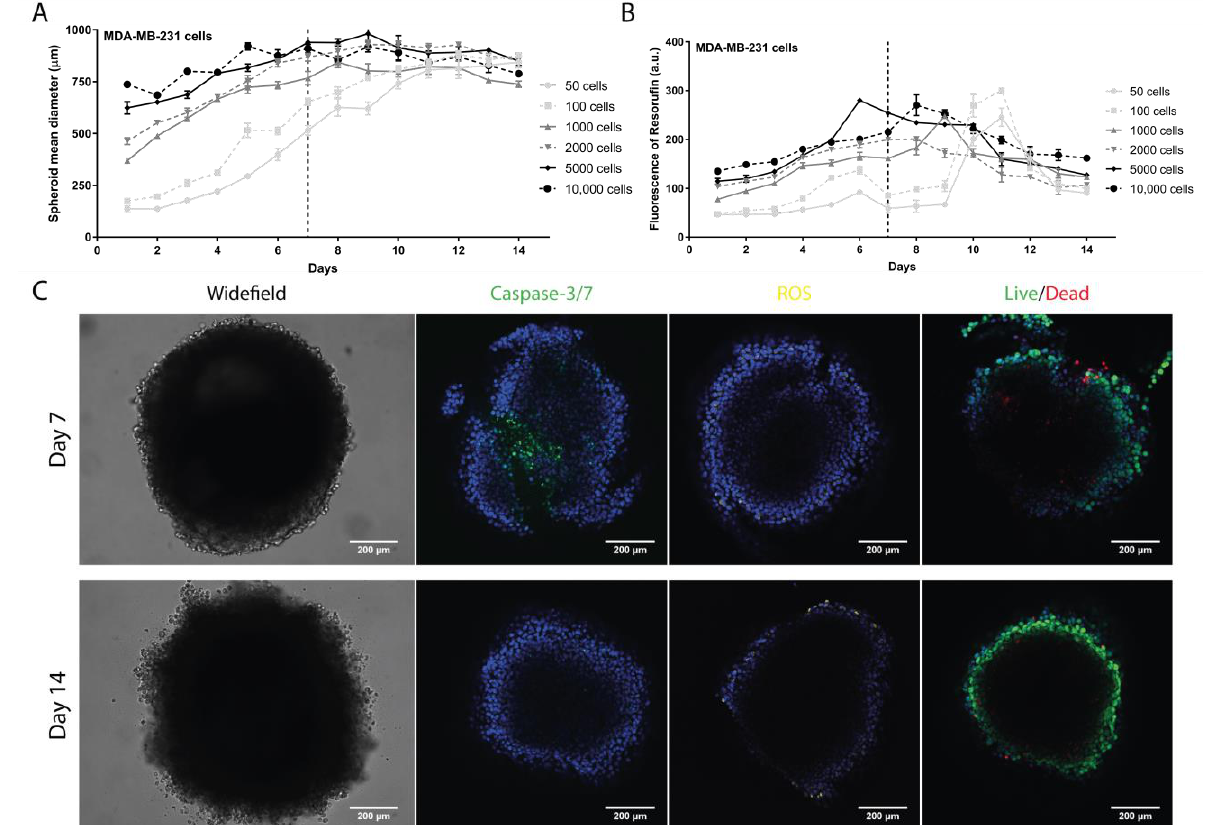
Figure 1. Evaluation of the MDA-MB-231 spheroid formation. ( A ) Spheroid diameter ( µ m) daily monitoring over 14 days measured with a widefield fluorescence microscope. ( B ) Spheroid cell metabolic activity daily evaluation over 14 days by measuring the fluorescence emission of resorufin with a microplate reader. ( C ) Representative images of parameters evaluated on days 7 and 14 at 2000 cells/well with a confocal point-scanning Zeiss LSM 880 microscope. In the apoptosis determination, apoptotic cells are marked in green; in the oxidative stress measurement, reactive oxygen species (ROS) are marked in yellow; and in the cell viability/mortality evaluation, intact cells (live) are marked in green and permeabilized cells (dead) in red. In all experiments, cell nucleus is marked in blue. Scale bar = 200 µm. Graphs represent at least three biological repeats.